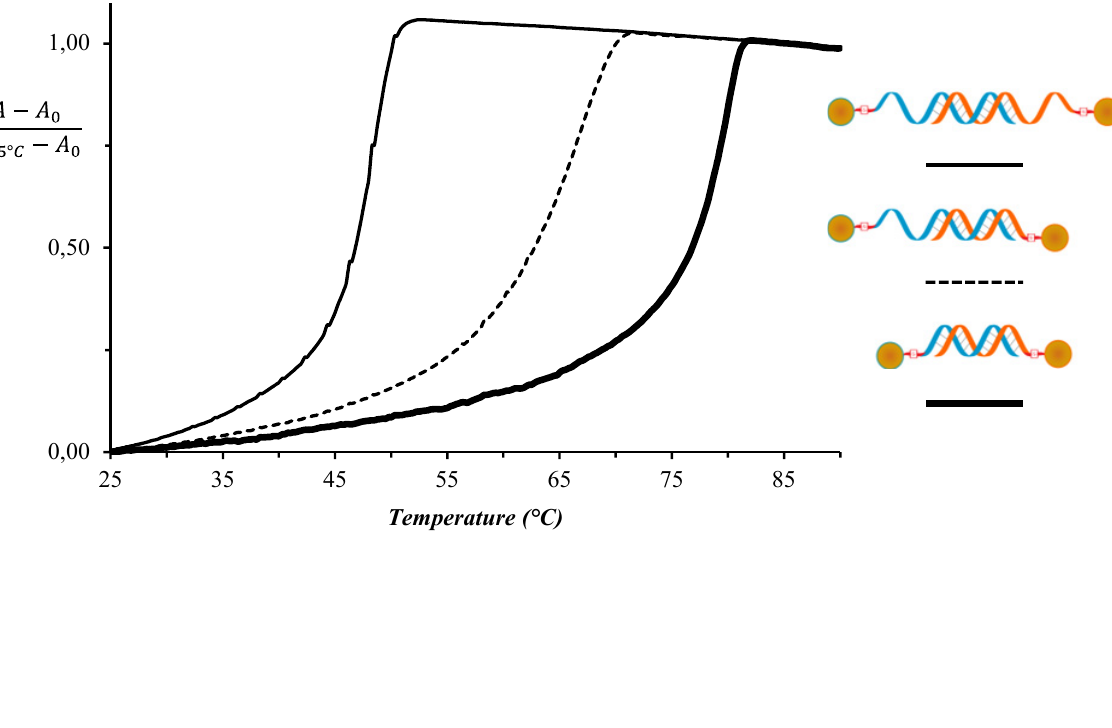
& DNAT (plain), 11 11 & T10- DNAT (bold) as a function 11 11